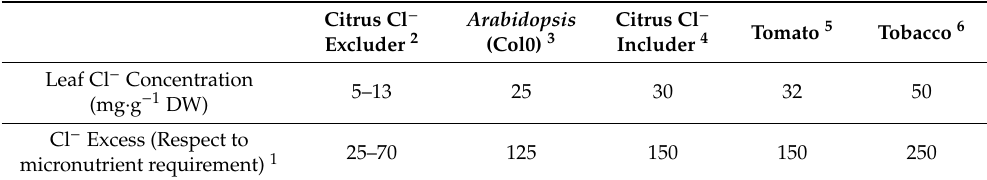
Figure 2. Stimulation of tobacco plant growth by macronutrient Cl − contents. The data, obtained from Franco-Navarro et al. [2] and from Colmenero-Flores et al (umpublished results) illustrates growth stimulation in terms of dry weight biomass in a range of leaf Cl − contents within the beneficial macronutrient range, which clearly overlaps with the previously reported toxic contents for this species [5]. There is a widespread belief that the accumulation of Cl − in plant tissues does not necessary reflect the quantity requested. Chloride applications in the 1 – 5 mM Cl − range determine increasing values of leaf Cl − accumulation in a linear fashion, which in turn determine positive responses in terms of dry biomass, strongly supporting that plants regulate the required amount of Cl − within the beneficial macronutrient range. Although the response remains positive with the application of 5 mM Cl − , the response curve inflection indicates that the trend can be reversed at higher Cl − concentrations. For example, in a similar assay, in comparison to the 5 mM Cl − treatment, 15 mM Cl − application resulted in lower dry weight, indicating that this concentration exceeds the beneficial range of Cl − nutrition. Table 1. Leaf Cl − Concentration in different plant species grown with nutrient solutions containing Cl − in the low milli-molar range (4.5 – 5.0 mM). Citrus Cl −